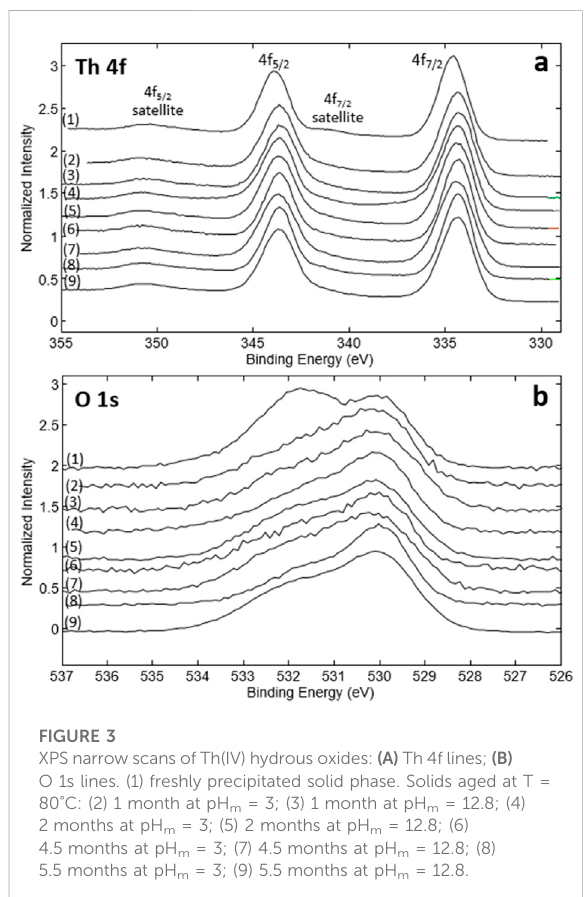
FIGURE 3 XPS narrow scans of Th(IV) hydrous oxides: (A) Th 4f lines; (B) O 1s lines. (1) freshly precipitated solid phase. Solids aged at T = 80 ° C: (2) 1 month at pH m = 3; (3) 1 month at pH m = 12.8; (4) 2 months at pH m = 3; (5) 2 months at pH m = 12.8; (6) 4.5 months at pH m = 3; (7) 4.5 months at pH m = 12.8; (8) 5.5 months at pH m = 3; (9) 5.5 months at pH m =